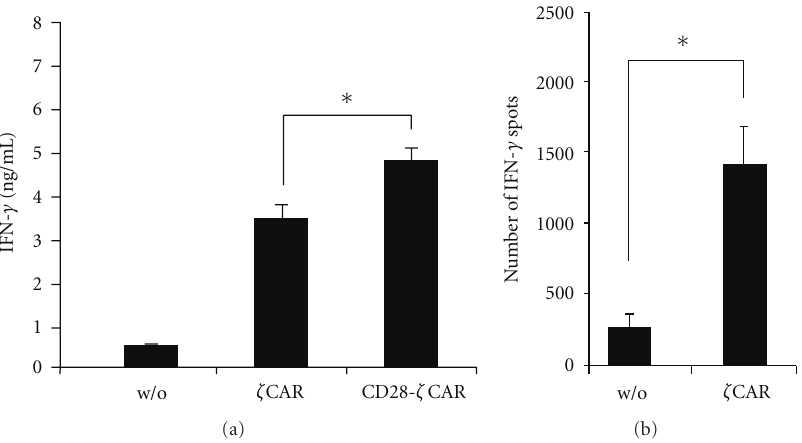
Figure 4: Activation of CIK cells from cancer patients against autologous colon carcinoma cells. Primary colon carcinoma cells were isolated from a colon carcinoma biopsy as described in Section 2 and cultured in vitro for short term. CIK cells from the same patient were generated in vitro and engineered with the ζ and the CD28- ζ CAR. CIK cells were coincubated for 48hrs with the autologous CEA + colon carcinoma cells (4 × 10 4 CIK cells; 10 3 tumour cells). Secreted IFN- γ in the culture supernatant was monitored by ELISA. Data represent the means of triplicates ± standard error of the mean. One representative experiment out of three is shown. ∗ P < 0 .